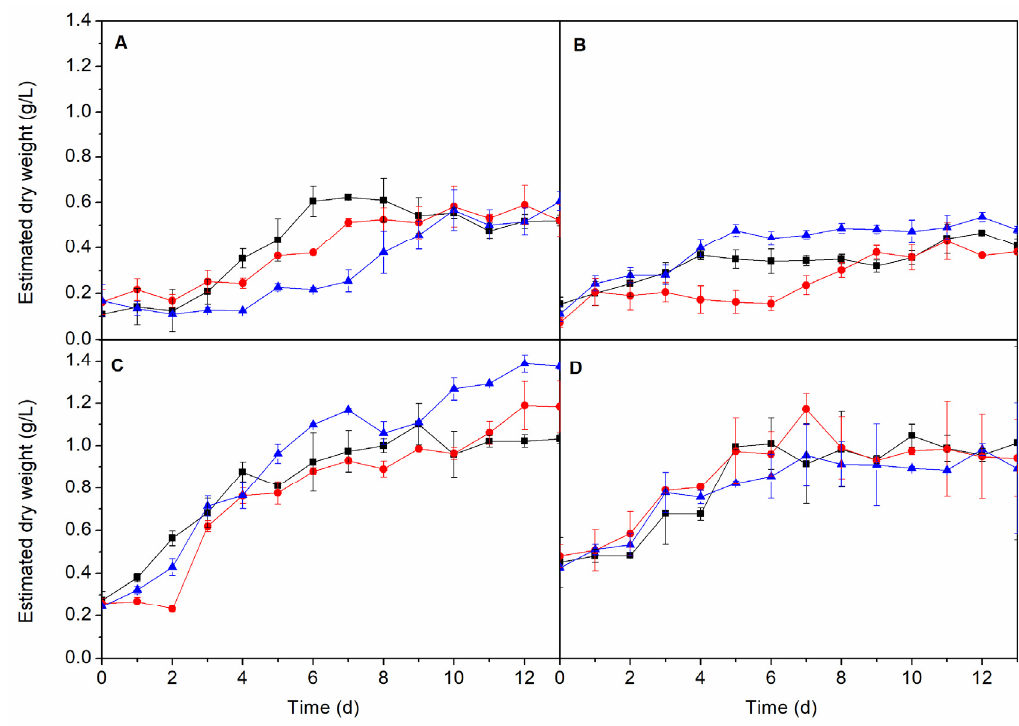
Figure 7. Growth of A. maxima ( A ), C. vulgaris ( B ), I. galbana ( C ) and N. gaditana ( D ) with different wastewater ( ■ AD1, ● AD2, ▲ AD3). Conditions for all cultivations: inoculum:culture medium ratio of 5:45 and a photoperiod of 12:12 h.